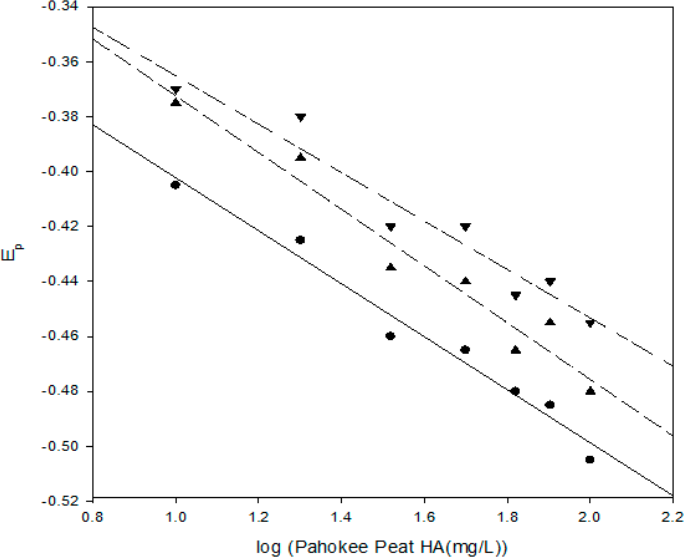
Figure 6. DPP results for Pb 2 + at pH 8 plotted as a function of the log of the Pahokee peat humic acid concentration (mg / L) at three di ff erent concentrations of Pb 2 + ( • 1.61 uM, (cid:78) 4.82 uM and (cid:72) 9.63 uM).